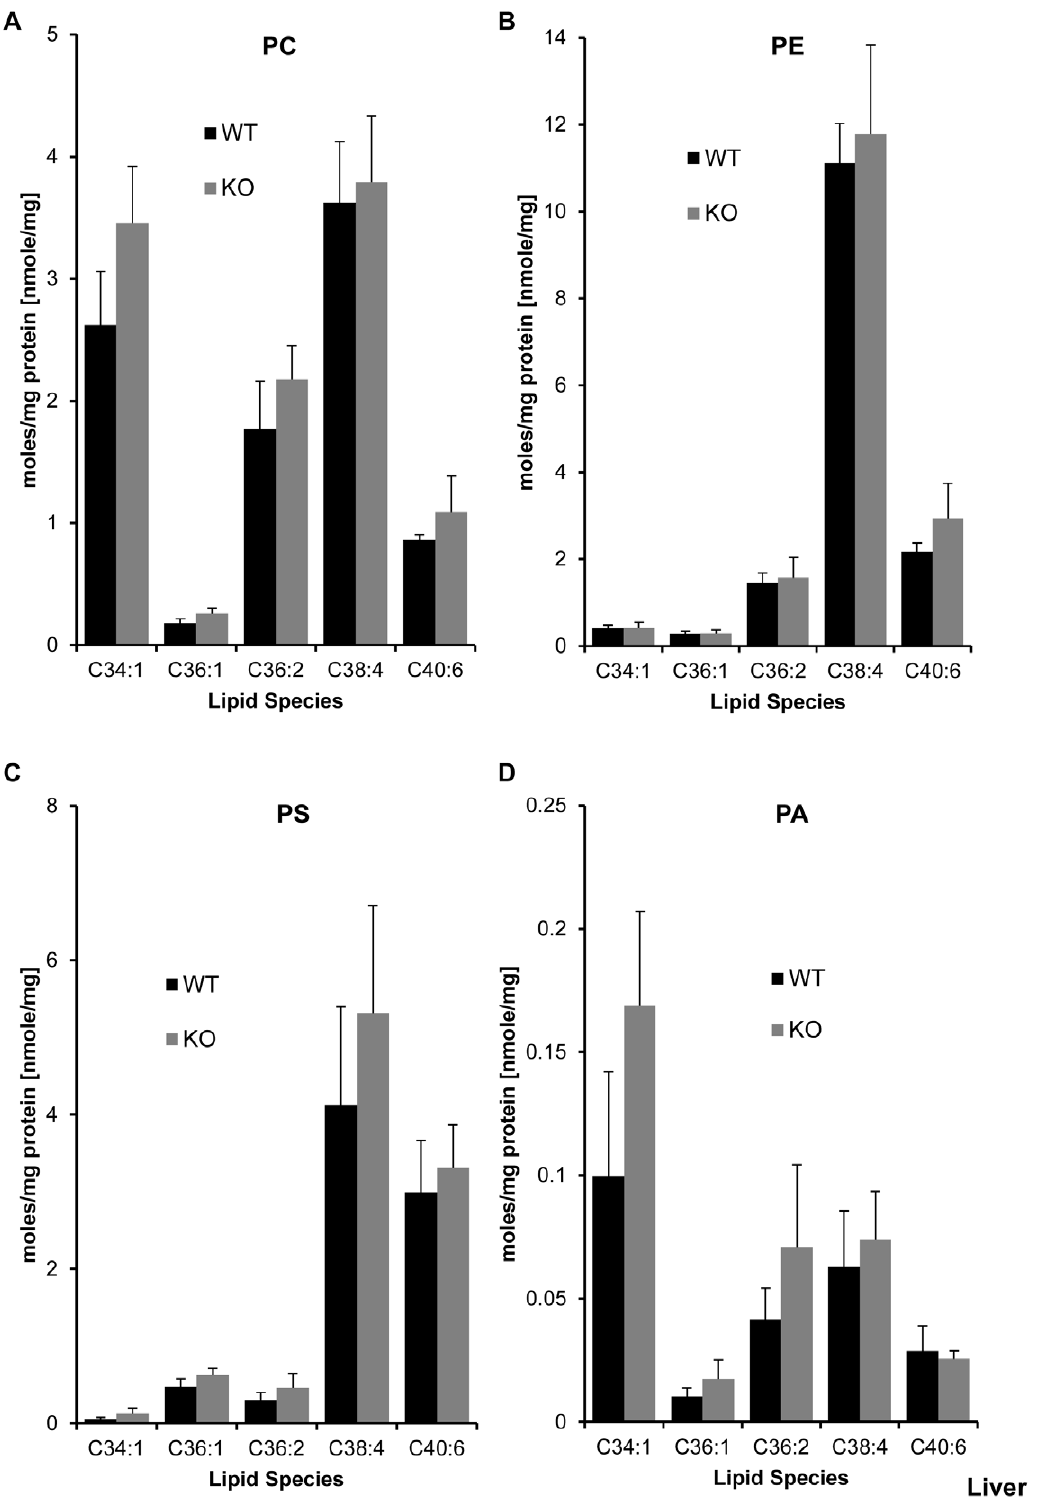
Figure 2. Effect of LPIAT1 knockout on liver phospholipid molecular species. Livers from 13 day old littermates expressing (LPIAT1 + / + (WT)) or lacking (LPIAT1 2 / 2 (KO)) LPIAT1 were homogenized and lipids extracted from 0.5 mg wet weight as described in Materials and Methods. Targeted molecular species of PC ( A ), PE ( B ), PS ( C ) and PA ( D ) were detected by MRM mass spectrometric analysis as described in Materials and Methods. Data are expressed as moles/mg protein, normalized to relevant internal standards. Shown are mean 6 SD, n=4 for both WT and KO. Data were analyzed by T-test.